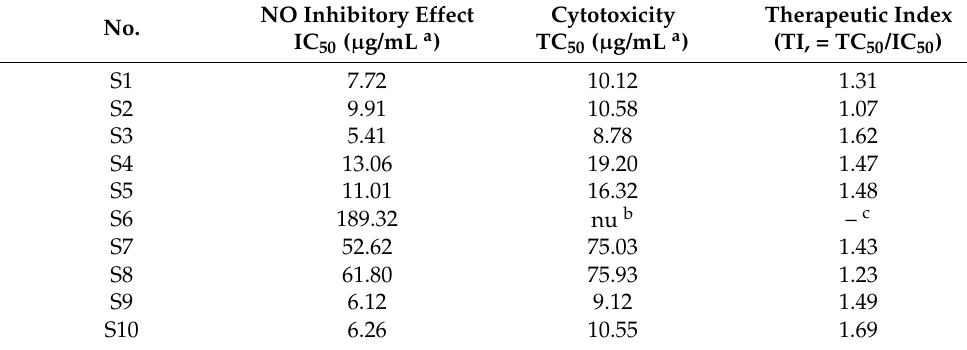
Table 6. NO inhibitory effects of TGTs in LPS-induced RAW 264.7 cells and their cytotoxicities against RAW 264.7